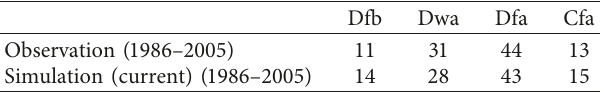
Table 3: Change in area of four climatic zones for observation and simulated climates (unit: